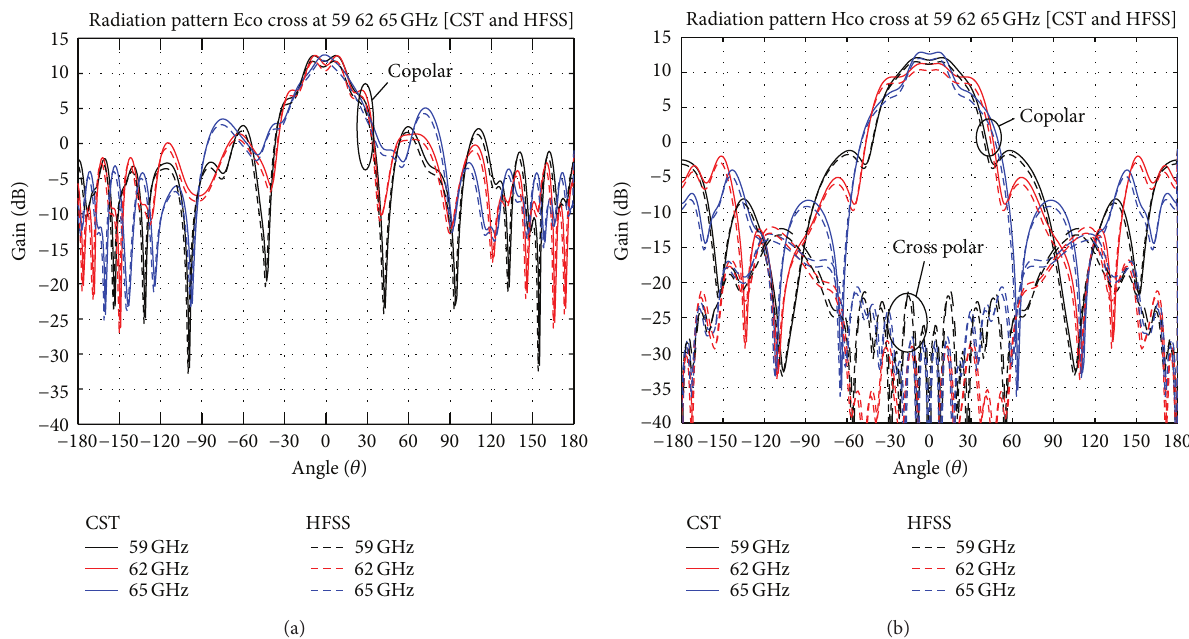
Figure 3: (a) Simulated E-plane radiation pattern at 59, 62, and 65 GHz and (b) simulated H-plane radiation pattern at 59, 62, and 65 GHz.